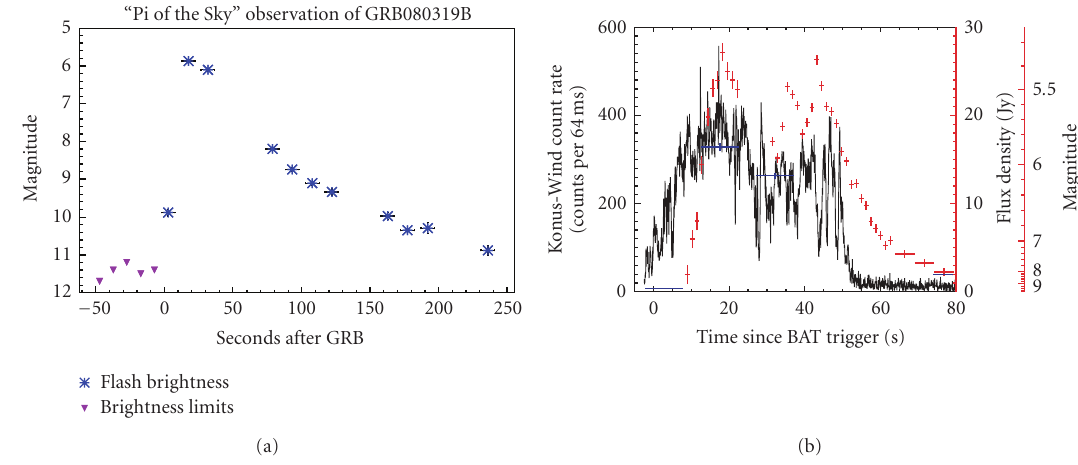
Figure 5: Light curve of GRB 080319B prompt emission. (a) shows “Pi of the Sky” measurements alone. (b) (taken from Racusin et al. [18]) shows the “Pi of the Sky” (blue), “TORTORA” (red), and Wind-Konus (black) data.